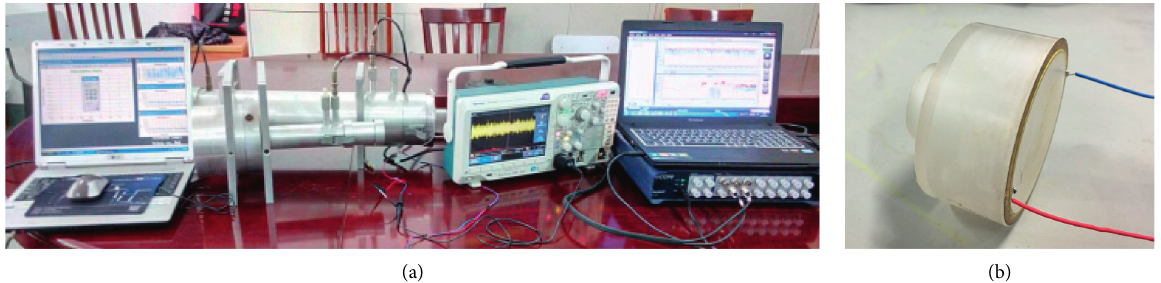
Figure 17: The photos of the experiment system: (a) experiment setup and (b) acoustic energy